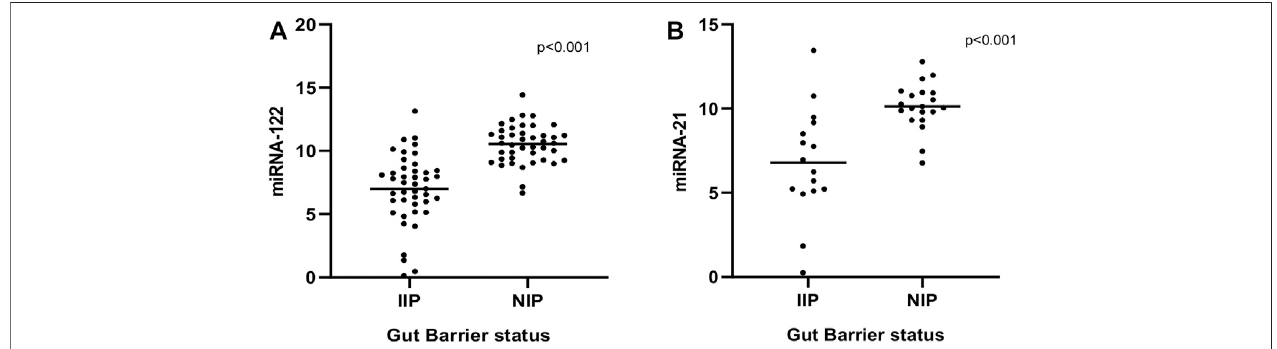
FIGURE 2 | Area under curve (AUC) of receiver operating characteristic (ROC) analysis for miR-122 and miR-21 relative expression in fecal samples for discriminatingincreasedandnormalintestinalpermeability.ROCcurveanalysisrevealedthatfecalmiR-122andmiR-21relativeexpressionhassigni fi cantspeci fi cityand sensitivity todistinguishbetween children with IIP and NIP. (A) : miR-122yield an area under the curve (AUC) value of0.893 ( p -value (cid:1) 0.0001). (B) : miR-21 yield an area under the curve (AUC) value of 0.850 ( p -value (cid:1) 0.0001).